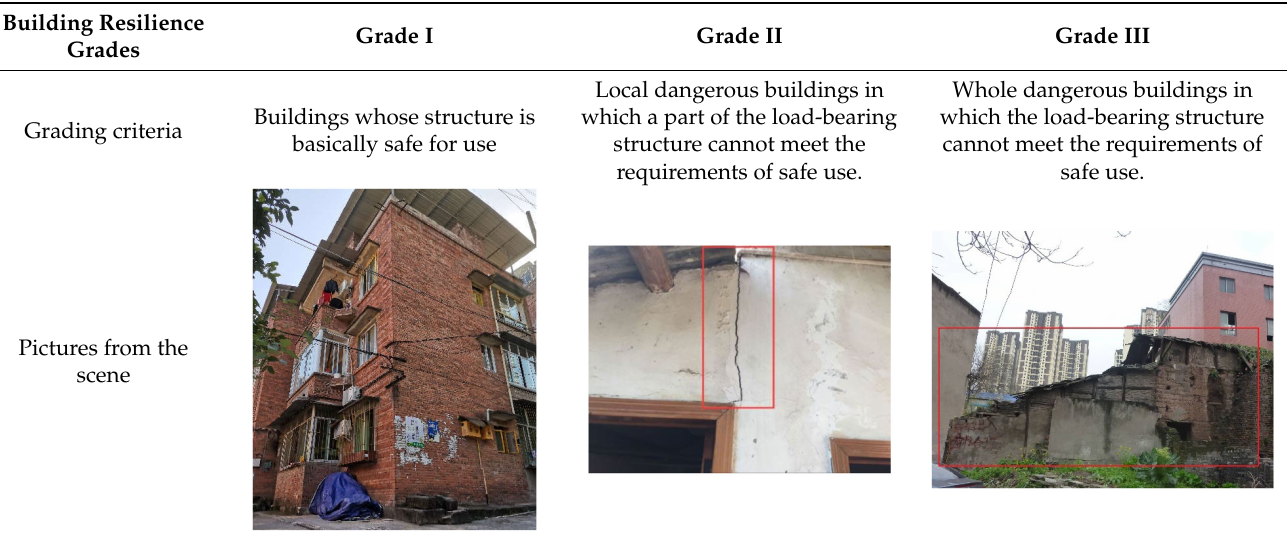
Table 5. RF and SVM optimization model evaluation indexes for the test samples.